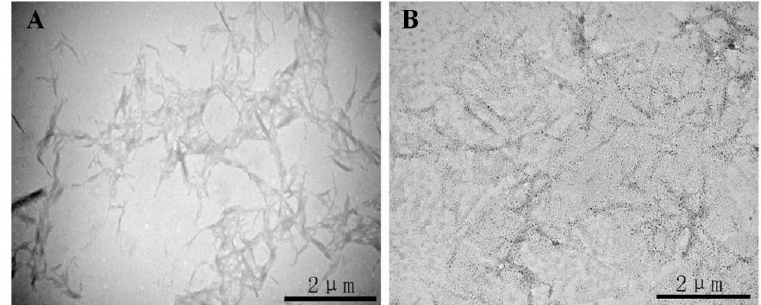
Figure 1. Transmission electron microscopy (TEM) pictures of CNCs-Ag composite: cellulose nanocrystals (CNCs) ( A ); CNCs-Ag ( B ).